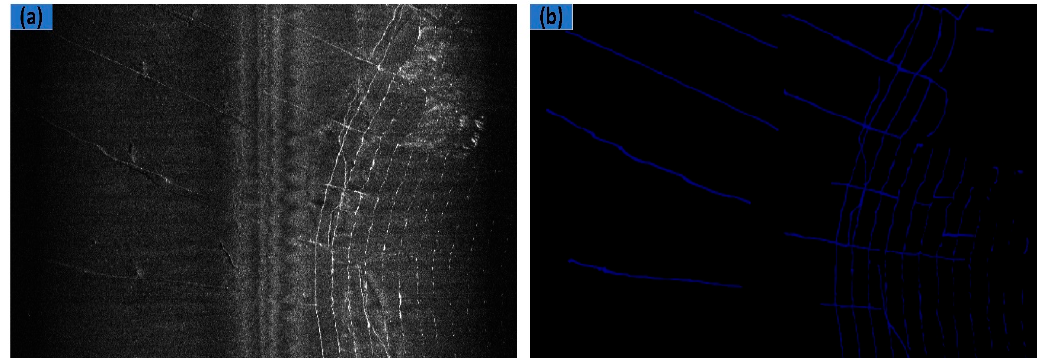
Figure 5. Examples of our data: ( a ) The results of the interpolation and removal operation used to form dataset; ( b ) corresponding ground truth.